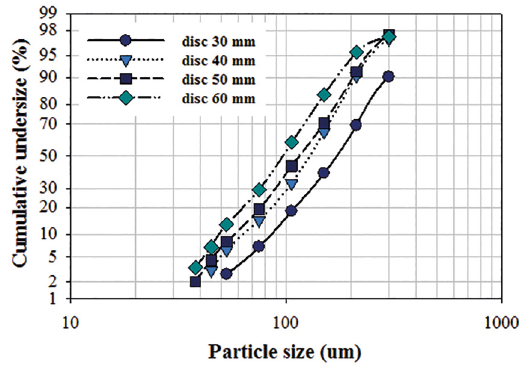
Figure 6. Effect of atomising disc diameter on particle size distribution. Rotating speed 30,000 rpm, 50 kg/hr melt feed